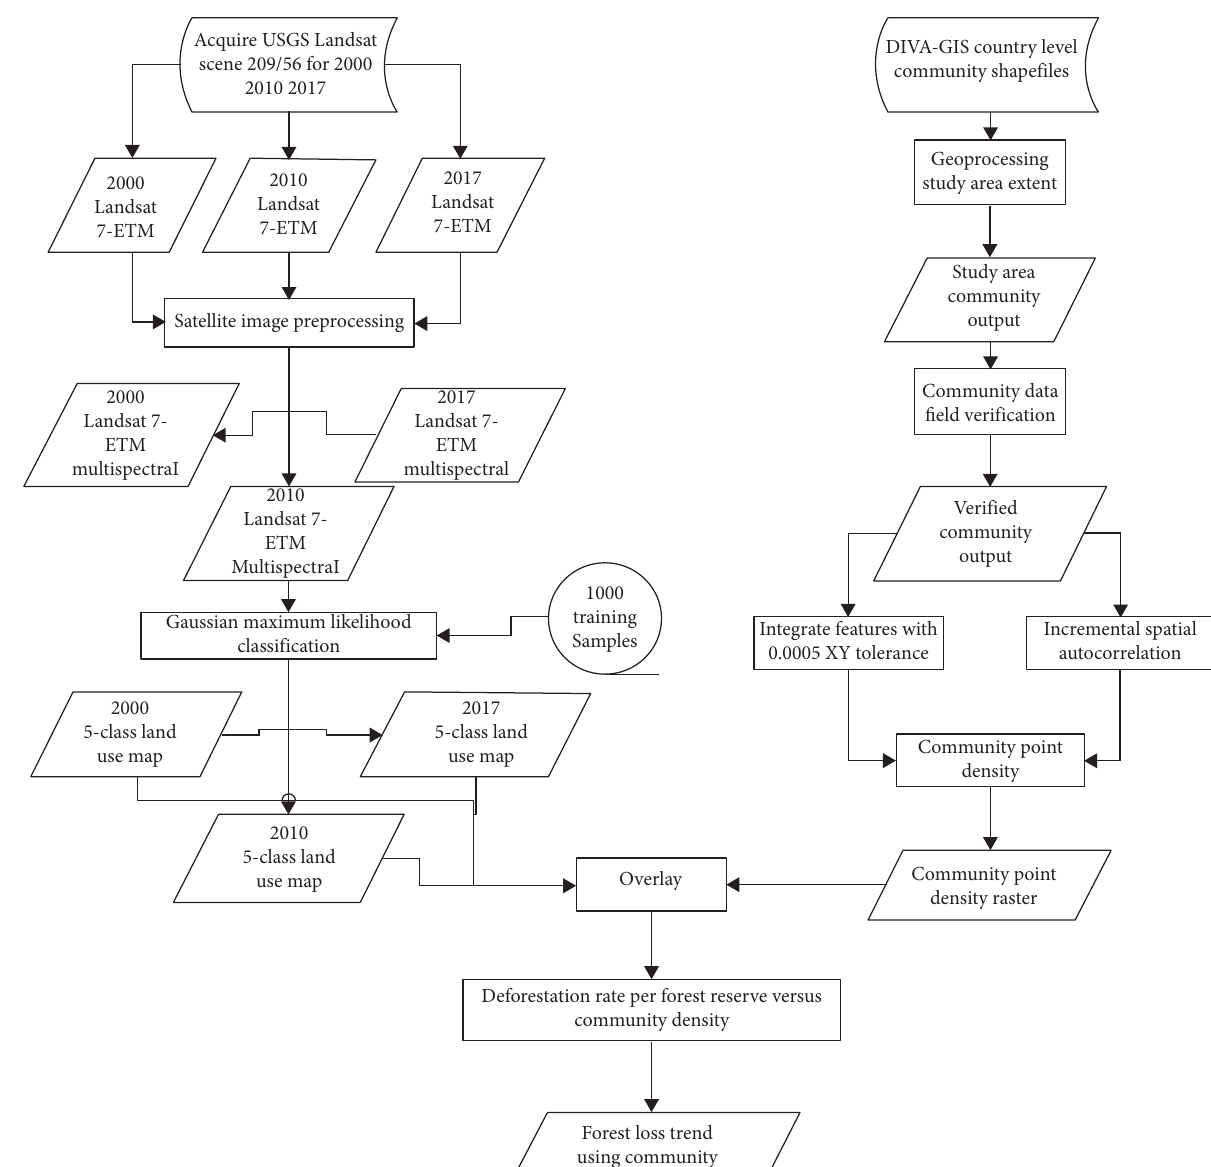
Figure 7: A workflow of community shapefile processing and subsequent LULC (iii) (Shown yellow) Predicted pixel area and original pixel area for a time interval used to calculate the mean absolute deviation and predicted pixel area error (iv) Predicted pixel area for 2024 using the predicted pixel area error and mean absolute deviation